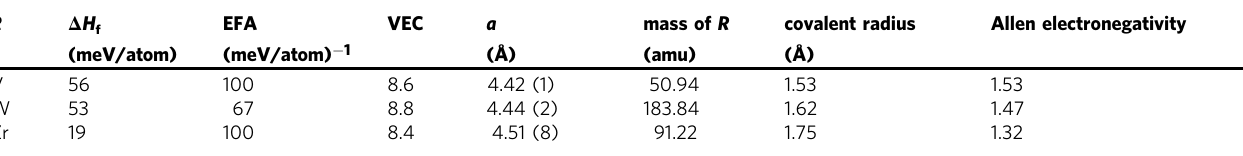
Table 1 Structural and thermodynamic parameters of the high-entropy carbide model